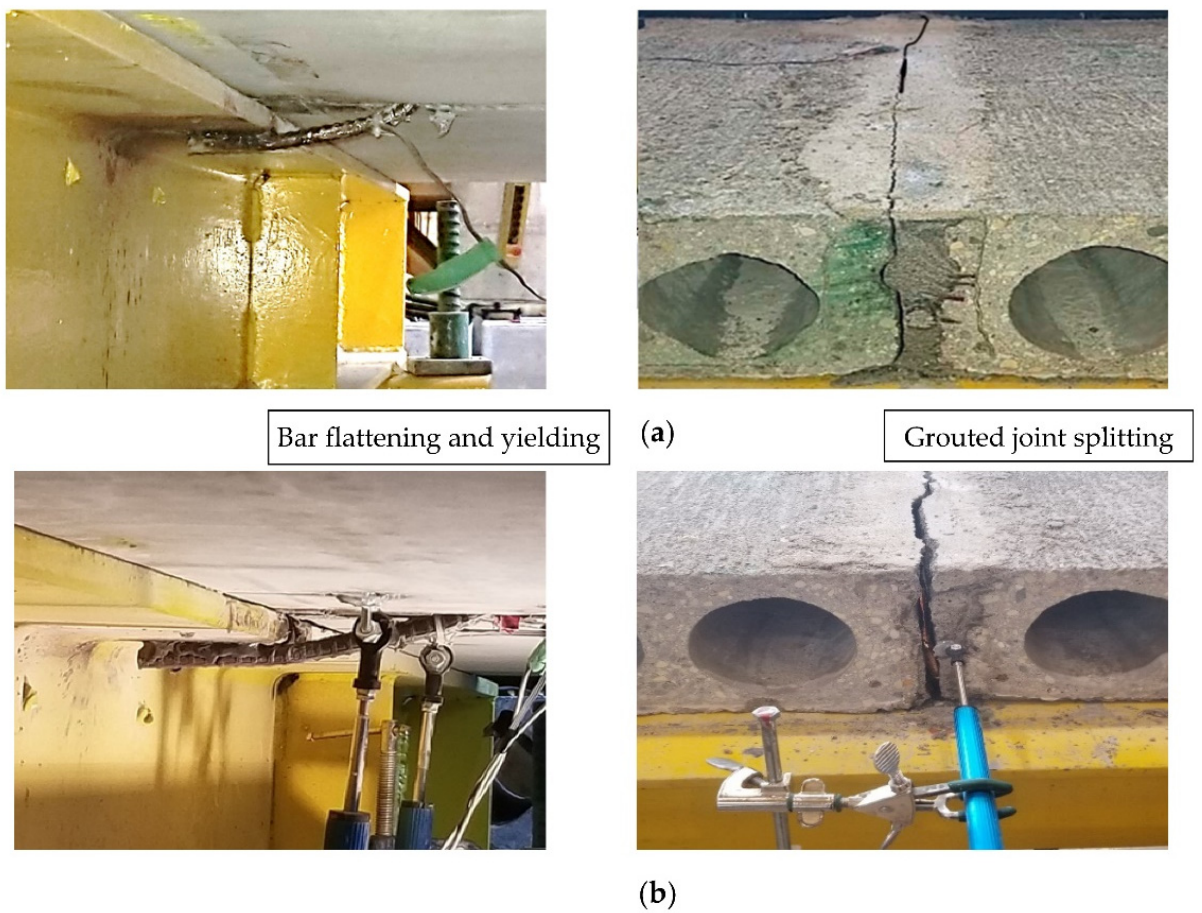
Figure 6. Mode of failure for end-bearing specimens tested under axial pulling (tension forces):